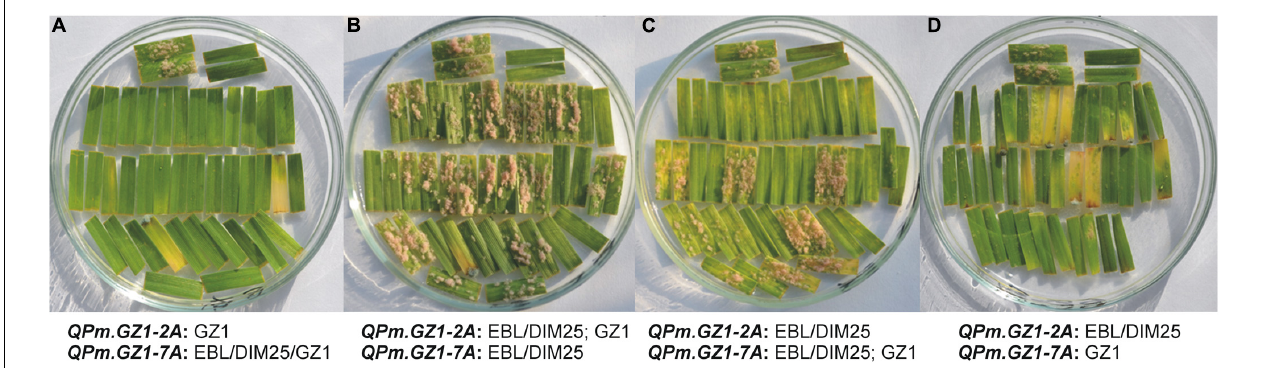
FIGURE 3 | Phenotypic reaction of F 2 : 3 families to a mixture of powdery mildew isolates A17, A23, and A3ab focusing on the interaction between QPm.GZ1-2A and QPm.GZ1-7A . Examples of phenotypic reactions of individual F 2 lines with allelic states of the resistance loci as indicated under the pictures (GZ1 = homozygous and resistant, EBL/DIM25/GZ1 = any allele, EBL/DIM25 = homozygous and susceptible, EBL/DIM25; GZ1 = heterozygous). In all pictures, the top two pairs of horizontally placed segments are susceptible control EBL (left) and resistant control GZ1 (right). For all F 2 lines, about 20 F 2 : 3 progenies were tested and each of them is represented by two leaf segments. (A) F 2 lines homozygous for the GZ1 allele at the QPm.GZ1-2A irrespective of the QPm.GZ1-7A showed complete resistance. (B) Lines that were heterozygous at QPm.GZ1-2A and carry the homozygous susceptible allele at QPm.GZ1-7A segregated in a ratio of 1 (resistant): 3 (susceptible). (C) Lines heterozygous at QPm.GZ1-7A and homozygous susceptible at QPm.GZ1-2A segregated in a ratio of approximately 3 (resistant): 1 (susceptible). Of 21 F 2 : 3 progeny lines, leaf segments of seven plants (7, 9, 12, 15, 18, 20, 21) were covered with large colonies, while segments of eight plants (1, 5, 6, 10, 11, 13, 17, 19) had very small colonies The remaining six plants (2, 3, 4, 8, 14, 16) had almost no visible colonies. (D) Lines that were homozygous for the GZ1 allele at the QPm.GZ1-7A but homozygous for the susceptible parent at the QPm.GZ1-2A inhibited infection of powdery mildew almost